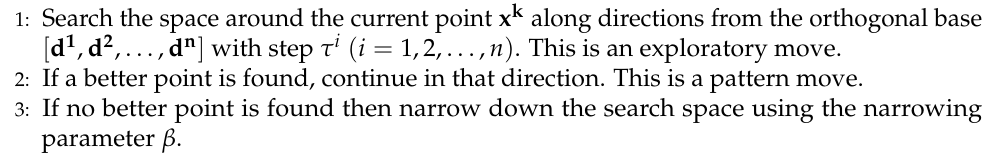
Algorithm 2 Hooke–Jeeves algorithm